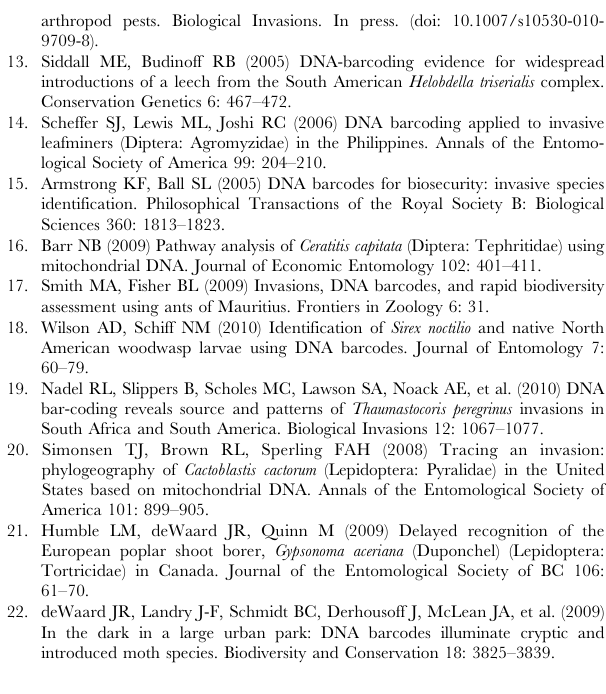
Figure S1 Complete maximum likelihood tree for 36 species of Lymantria . Full tree from Figure 3 displaying haplotype variation within species clusters. BOLD process IDs and collection localities are provided for each sequence. Tree was rooted with the outgroup Orgyia antiqua .